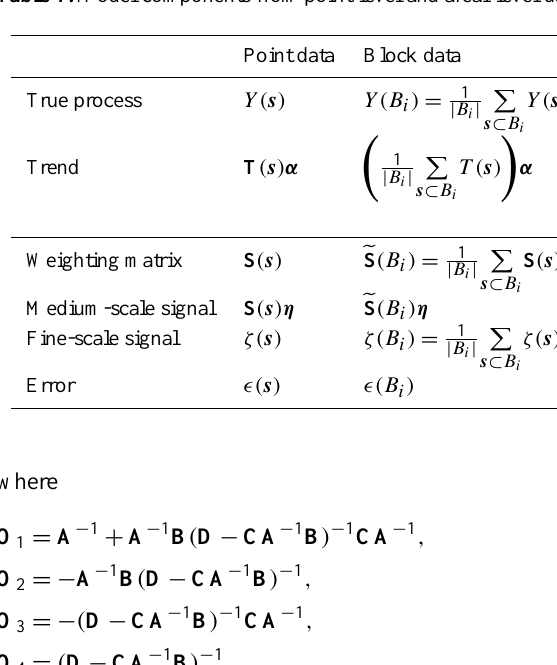
Table 1. Model components from point-level and areal-level data.